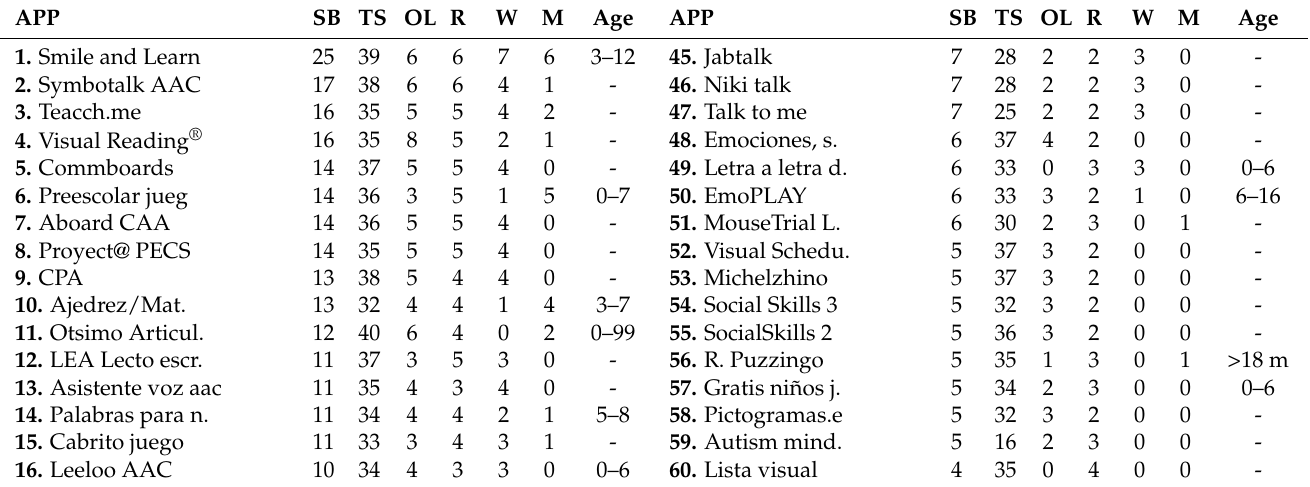
Table 4. Apps focused on Basic instrumental skills, ordered according to the score obtained in the assessment of all the skills. APP SB TS OL R W